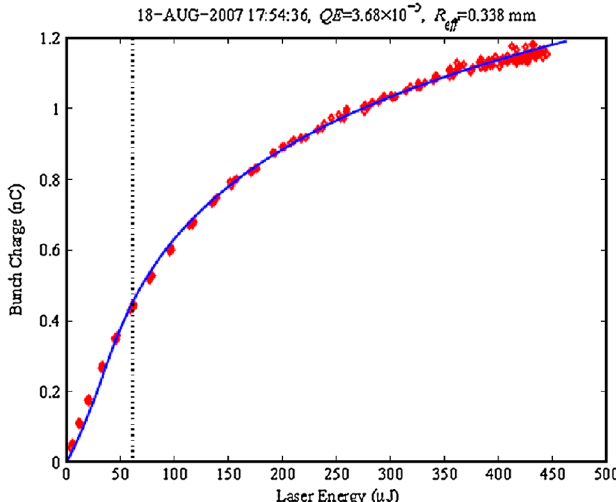
FIG. 17. (Color) The measured bunch charge vs laser energy fit with an analysis for the QE and the space charge limit. The QE in this case was 3 : 7 (cid:7) 10 (cid:1) 5 and the effective transverse radius is 0.34 mm